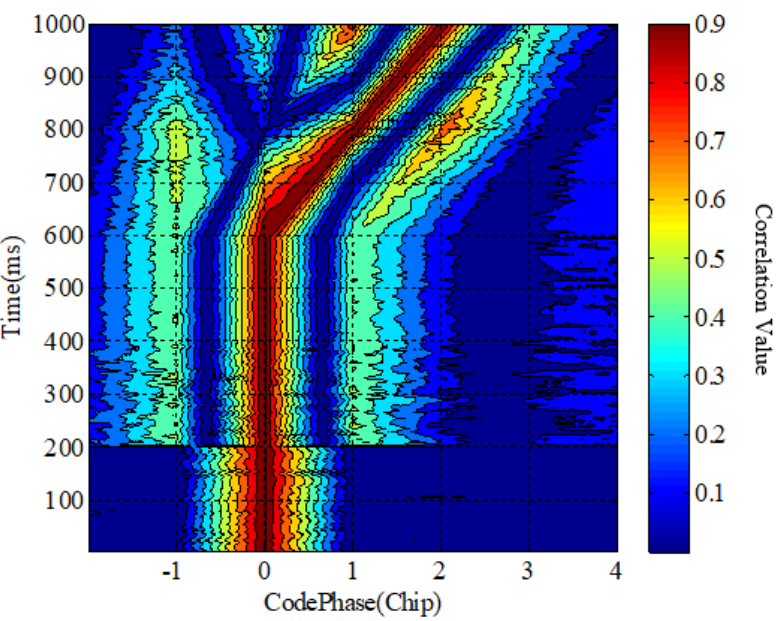
Figure 14. Waterfall diagram of the correlation function in an interference scenario.